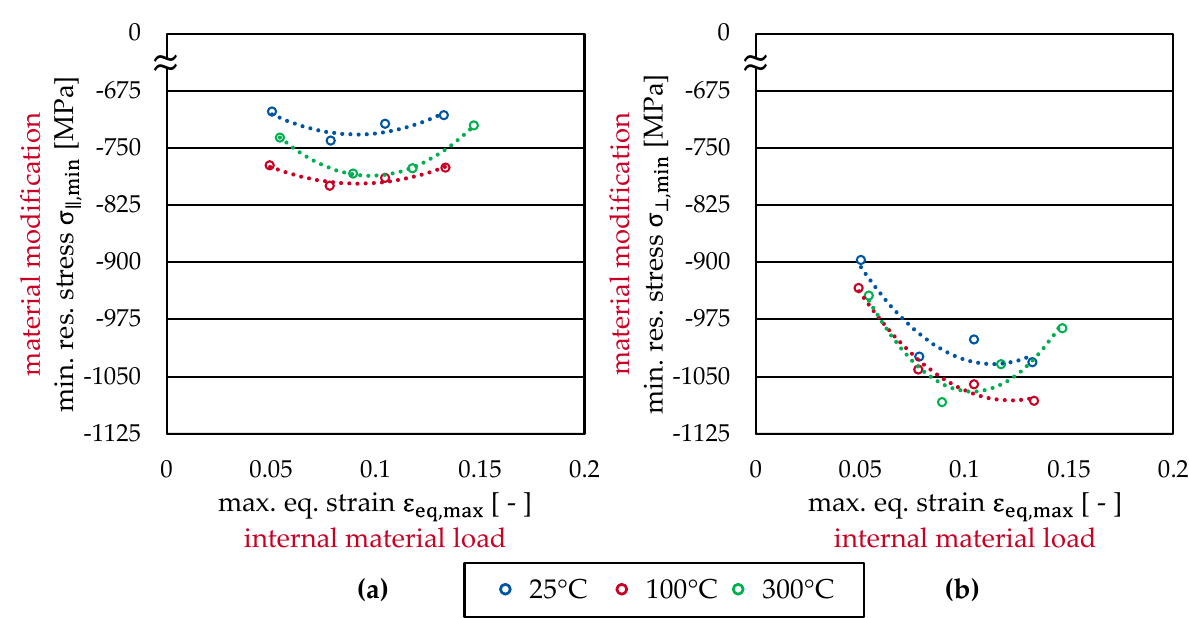
Figure 14. Simulated Process Signature Components for deep rolling describing the minimal residual stress components in dependence of the maximal equivalent strain at different workpiece temperatures ( a ) for the minimum residual stress parallel to the rolling direction ( b ) for the minimum residual stress perpendicular to the rolling direction. All values derived from simulations.